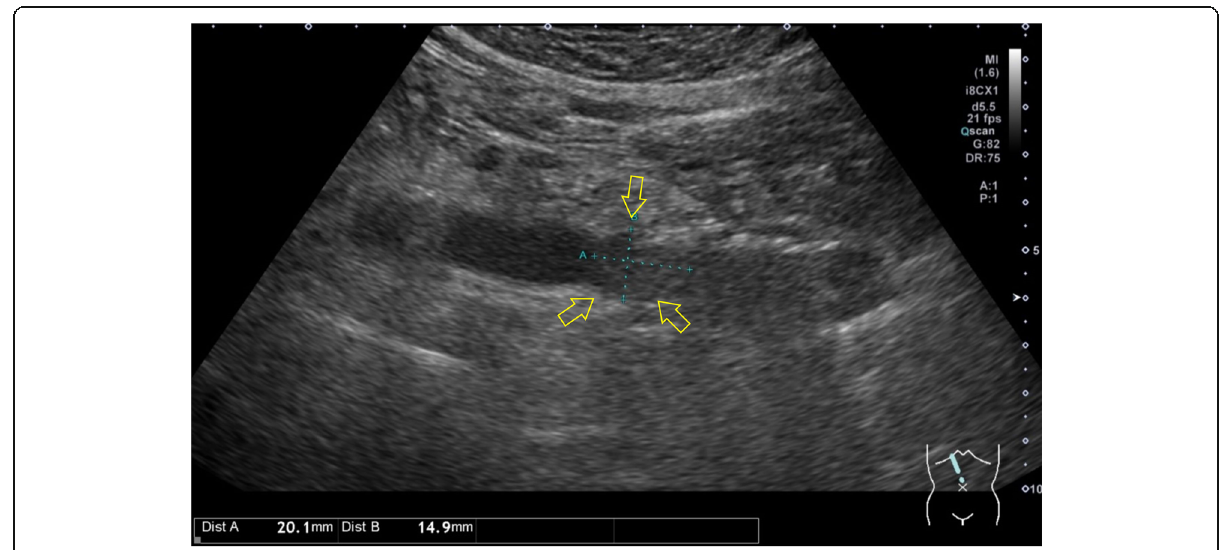
Fig. 1 Ultrasonography showed a 2-cm tumor in the distal bile duct